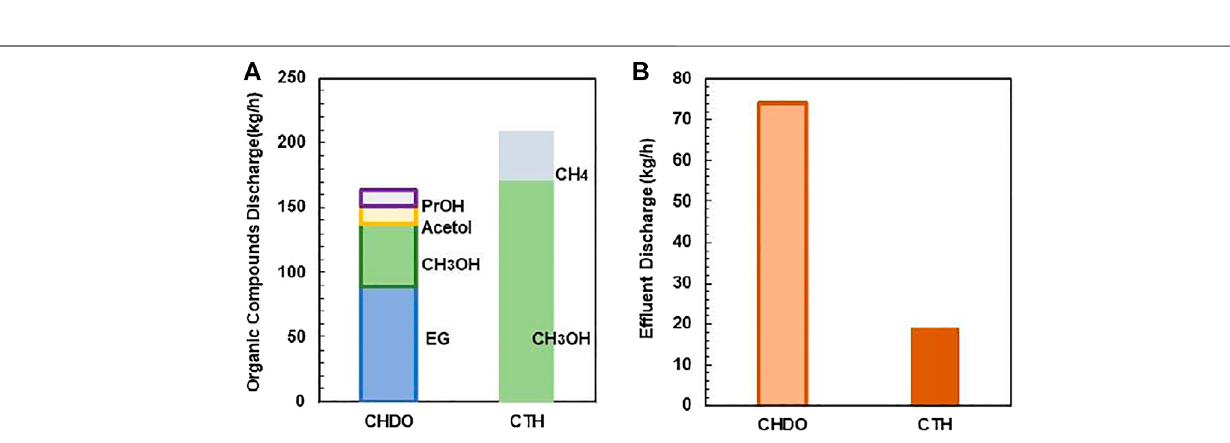
FIGURE 11 | The composition of the organic compounds of CHDO and CTH (A) . The ef fl uent discharge of CHDO and CTH (B) .